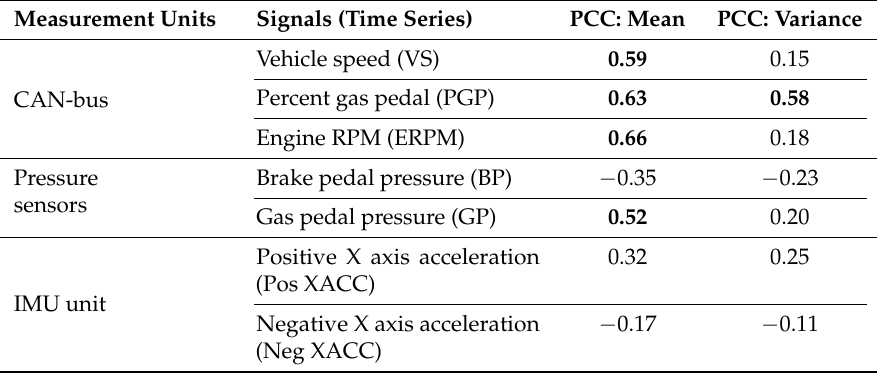
Table 2. Driving behavior signals and Pearson correlation coefficients (PCCs) of fuel consumption with relevant features. Mean values and variances are computed using 8 s analysis